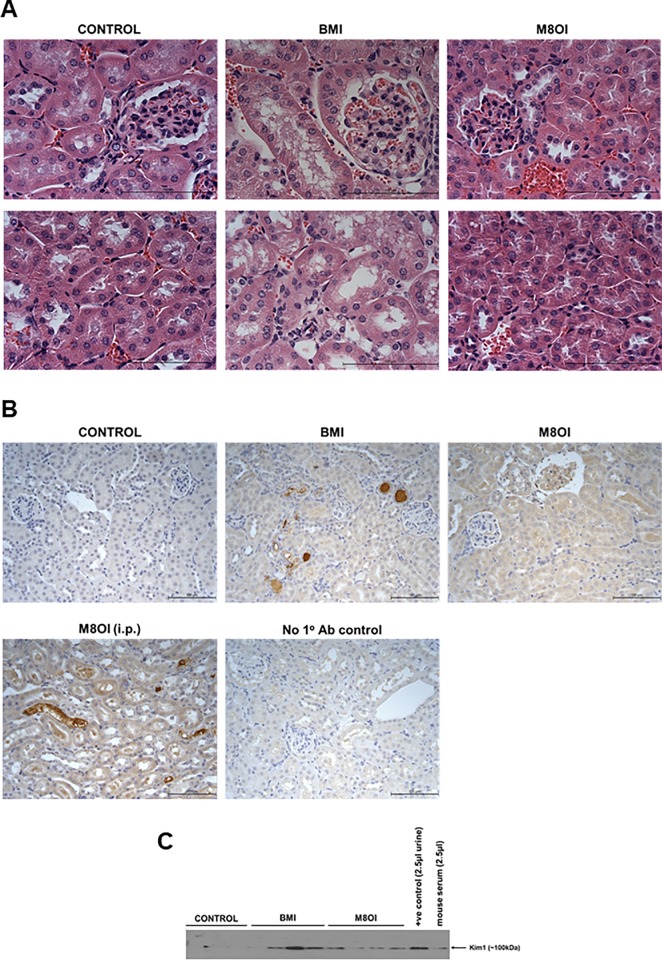
Histopathological effects of BMI or M8OI exposure in the kidney.A, typical views of kidney sections stained with H&E from the indicated treatment groups. Upper panels showing glomeruli, lower panels, tubules. B, typical views of kidney sections immunostained for kim1 from the indicated treatment groups. M8OI (i.p.) kidney section from a mouse administered M8OI via intraperitoneal injection; No 1o Ab, section treated identically without the addition of primary (i.e. kim1) antibody. Size bar = 100μm throughout. C, Western blot for kim1 in urine from individual mice (7.5μl/lane). +ve control, urine from a mouse administered M8OI via intraperitoneal injection [20].